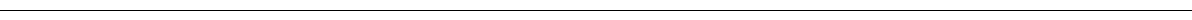
Fig. 3 K. pneumoniae O2 LPS is less immunogenic than K. pneumoniae O1 LPS. Puri fi ed O1 and O2 LPS were used for immunization of mice ( a ) or rabbits ( b ) with 0.5 mg LPS per animal. Immune sera were collected from O1 and O2 immunized animals and used to assess antibody titer against KP O1 or O2 LPS by ELISA. Sera from mock immunized animals with adjuvant only (black open circle) were used as a negative control. c Mice were immunized subcutaneously with either heat killed Kp1131115 (WT, an O1 strain) or the isogenic matched Kp1131115 Δ wbbYZ ( Δ wbbYZ, O2 serotype). Sera were collected 7 days after the fi nal injection and used to assess antibody titer against K. pneumoniae O1 or O2 LPS by ELISA. d Sera collected in c were used to assess antibody binding to a protein target (OmpA) and to proteinase K bacterial lysate by ELISA. e Immune activation of cells in vitro was compared for puri fi ed O1 and O2 LPS. RAW264.7 cells stably transfected with a NF- κ B driven luciferase promoter were stimulated with various doses of K. pneumoniae O1 or K. pneumoniae O2 LPS for 2 h. Percent activation was calculated as the amount of luminescence in stimulated cells vs. non-stimulated. Error bars indicate s.d. of each data point. f A schematic representation of KP O1 and O2 LPS. The gray region represents the membrane proximal LPS core region, the black region represents the D -galactan I ( D -gal I) repeating O antigen sugars, the hatched gray fi lled region represents the O1 speci fi c D -galactan II ( D -gal II) repeating O antigen sugars encoded by the wbbYZ locus. Deletion of this locus converted the O1 strain (Kp1131115 WT) to an O2 expressing strain (Kp1131115 Δ wbbYZ). g Silver stain of a SDS-PAGE gel showing the relative molecular weight of K. pneumoniae O1 LPS (lane 2) vs. K. pneumoniae O2 LPS (lane